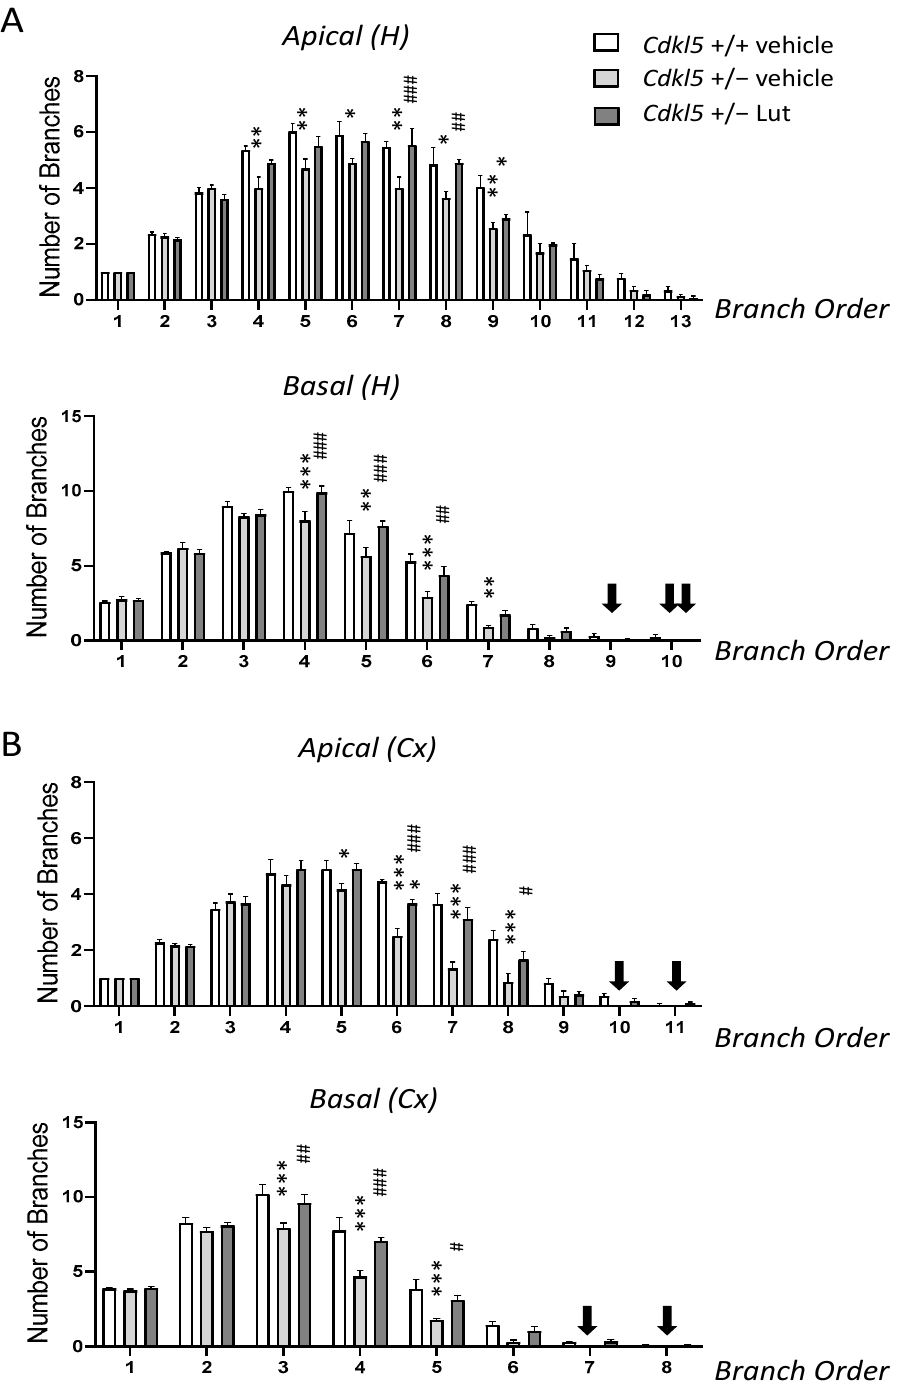
Figure 5. Effect of luteolin treatment on dendritic arborization complexity of hippocampal and cortical neurons in Cdkl 5 +/ − mice. ( A , B ) Quantification of the number of branches of different orders of apical dendrites (upper panel) and basal dendrites (lower panel) in Golgi-stained hippocampal ( A ) and cortical ( B ) pyramidal neurons of vehicle-treated Cdkl 5 +/+ (n = 4) and Cdkl 5 +/ − (n = 4) mice and luteolin-treated Cdkl 5 +/ − (n = 4) mice. Dendrites were traced in a centrifugal direction. Numbers indicate the different dendritic branch orders. Black arrows indicate the lack of branches of that order. H = hippocampus; CX = cortex. Values are represented as means ± SEM. * p < 0.05, ** p < 0.01, *** p < 0.001, as compared to the vehicle-treated Cdkl 5 +/+ condition; # p < 0.05, ## p < 0.01, ### p < 0.001, as compared to the vehicle-treated Cdkl 5 +/ − condition. Fisher’s LSD test after two-way